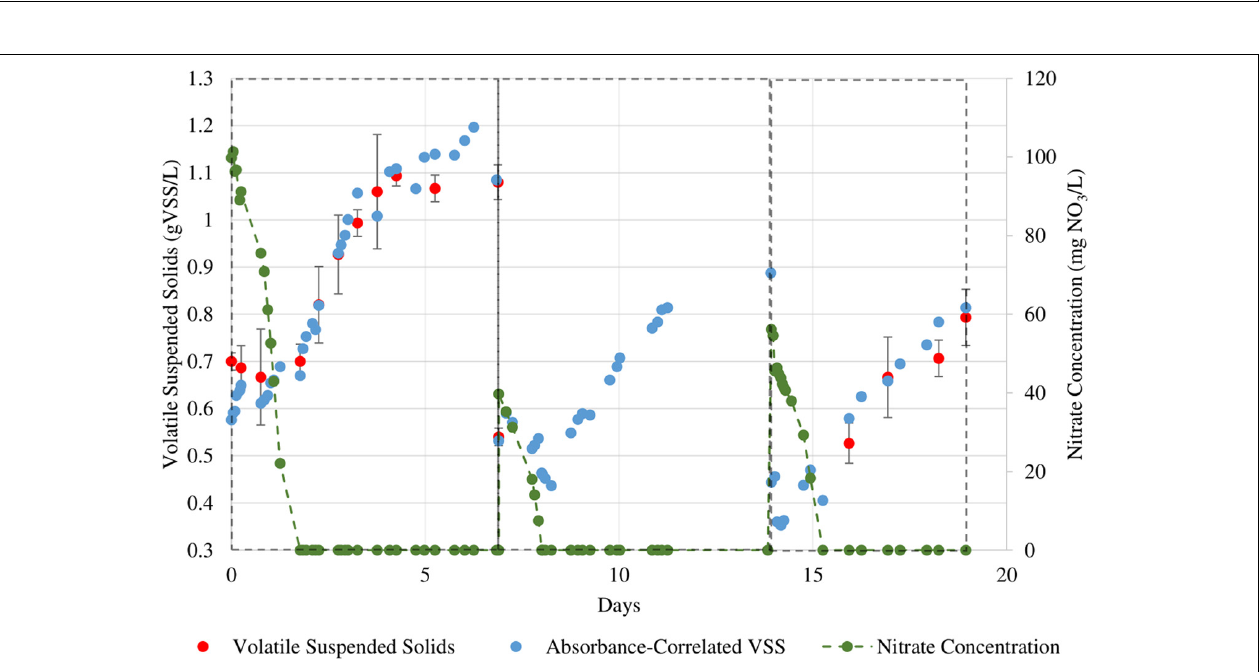
FIGURE 5 | Sequential growth batches of N. gaditana in which nitrate levels were more closely monitored. The initial NO 3 concentrations for the three cycles are 100, 40, and 56 mg/L respectively.